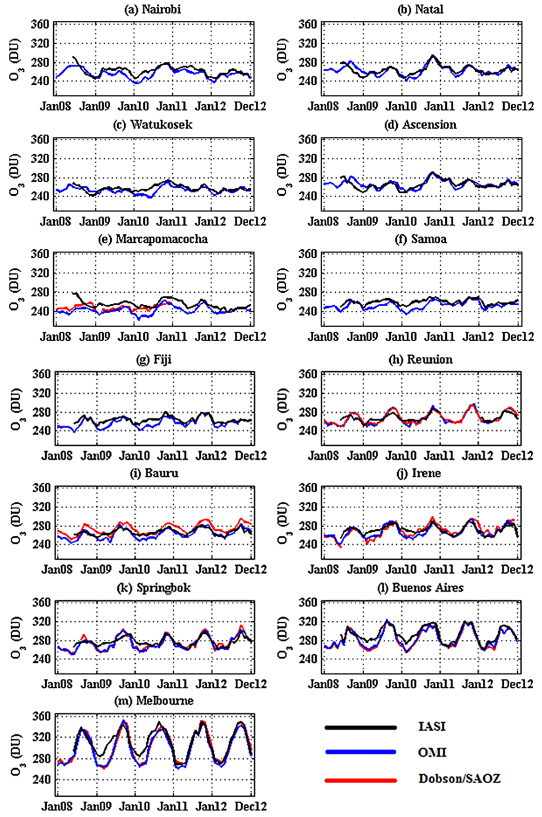
Figure 2. Comparison of the monthly mean TCO observed from July 2008 to December 2012 by IASI with OMI-TOMS, Dobson (over five stations) and SAOZ (over Réunion and Bauru stations). Graphics are numbered per station from (a) to ( m ). Station names and location are indicated at the top of each